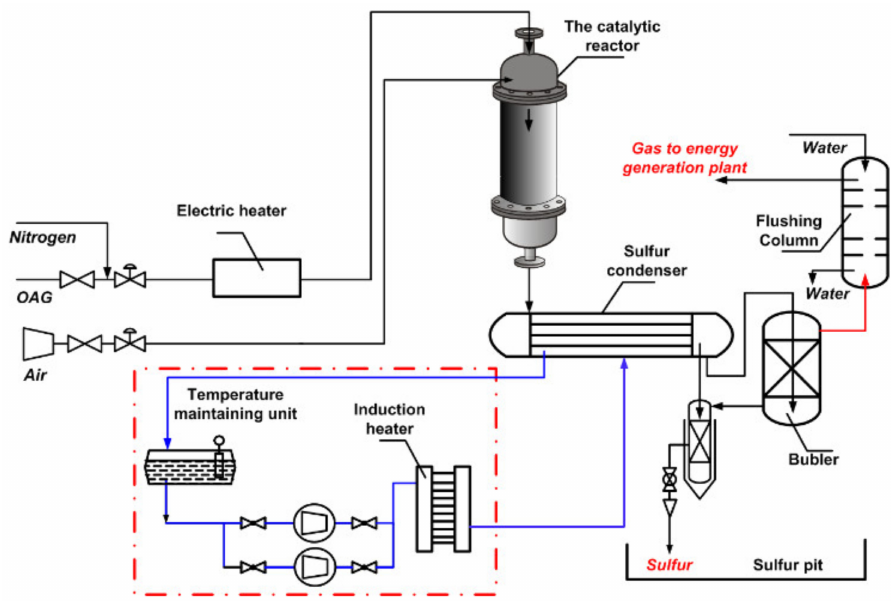
Figure 28. Flow-sheet diagram of the purification plant. Direct catalytic oxidation of hydrogen sulfide.